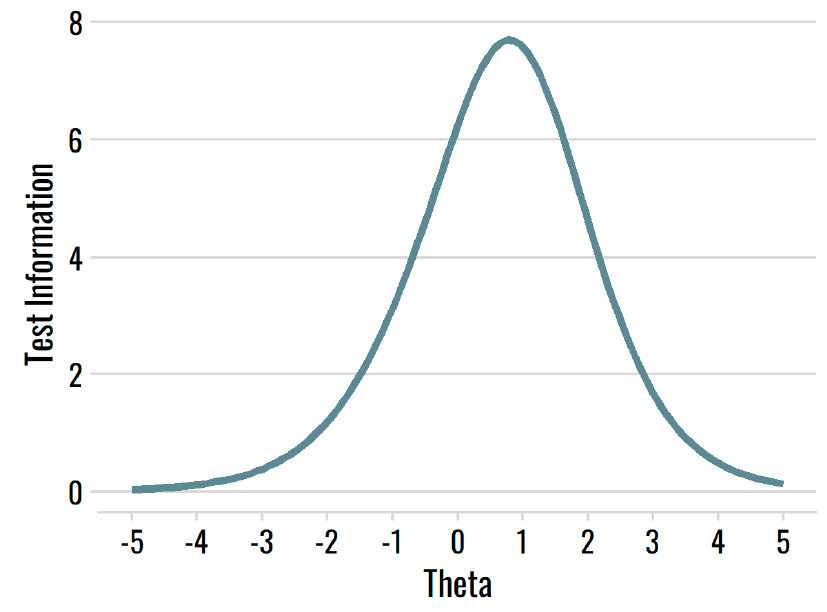
Figure 3. Test information function for the SAS.